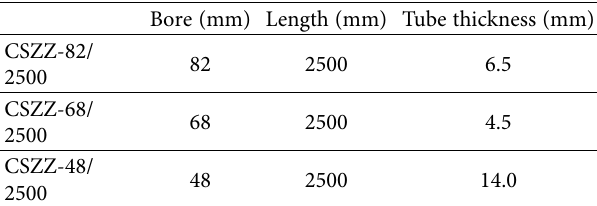
Figure 5: Sketch map of damage range of CO Table 1: Specifications and parameters of test